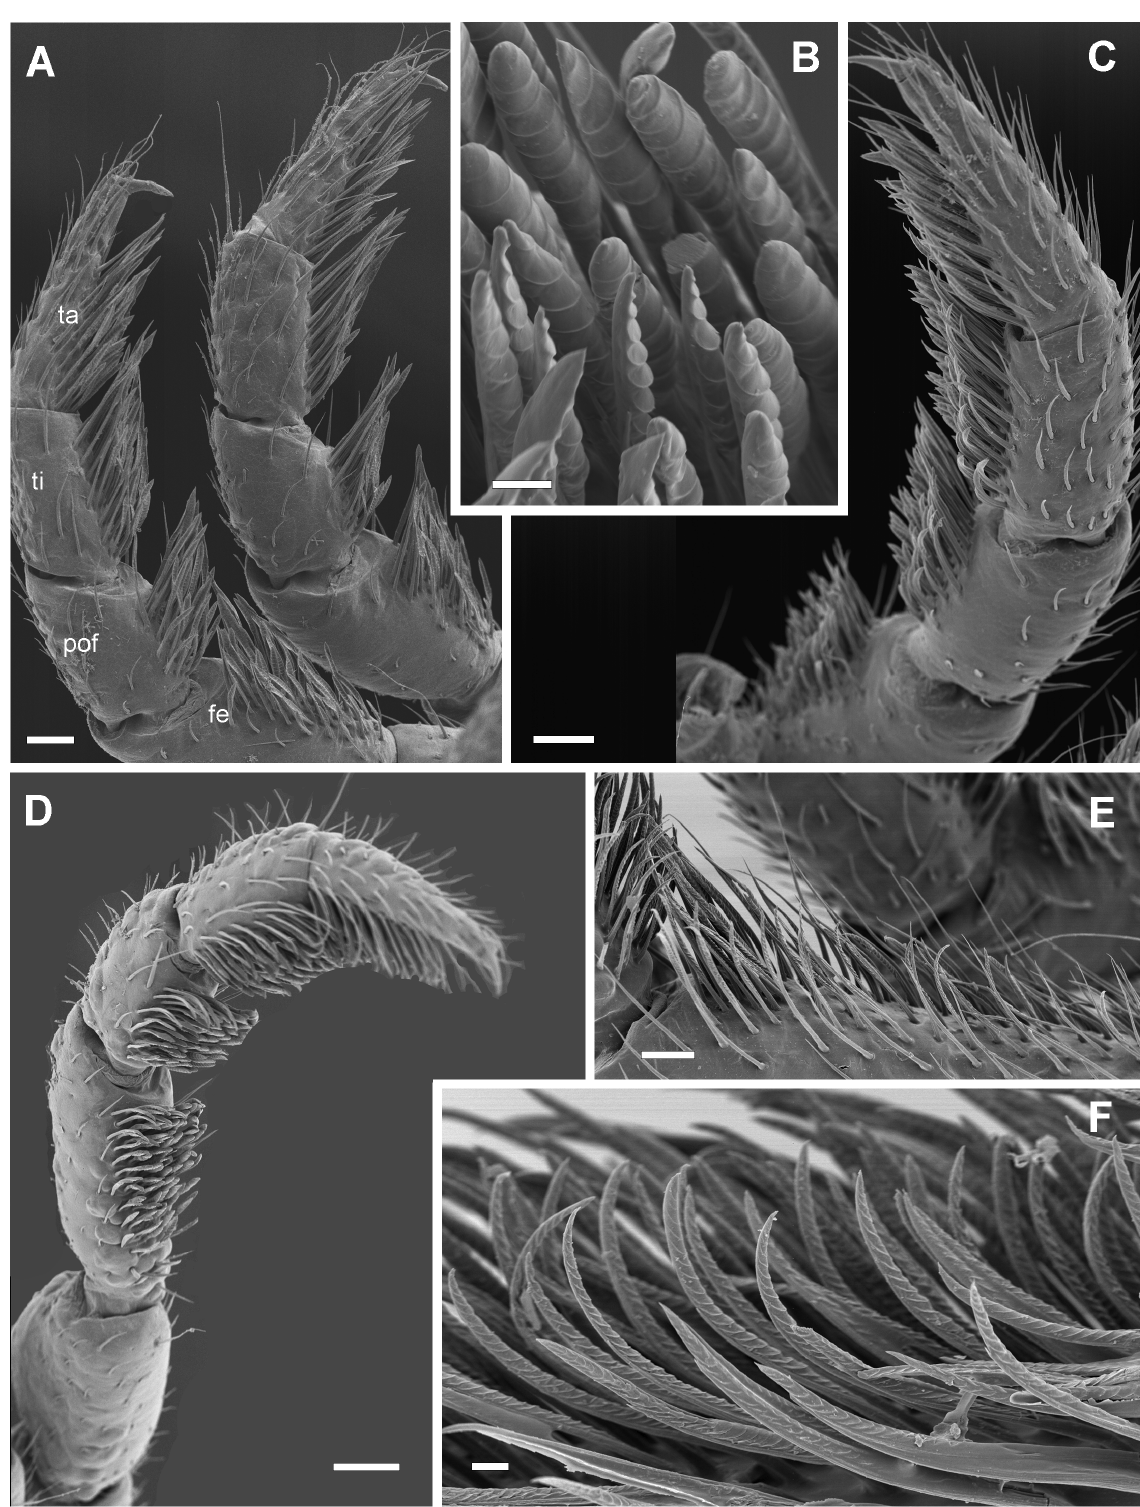
Fig. 7. Eviulisoma spp., scopulae on postfemur ( pof ), femur ( fe ), tibia ( ti ) and tarsus ( ta ) of male legs. A . E. paradisiacum sp. nov., paratype. B, D . E. cetafi sp. nov., paratype. C . E. ejti sp. nov., paratype. E–F . E. coxale sp. nov., paratype from Mito Mitatu. Scale bars: A, C, E = 0.05 mm; B, F = 0.01 mm; D = 0.1